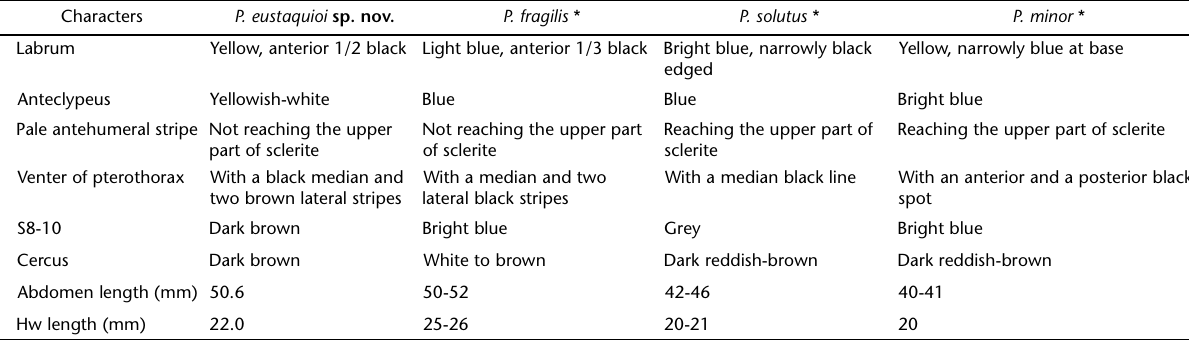
*Color characters according to W ILLIAMSON & W ILLIAMSON